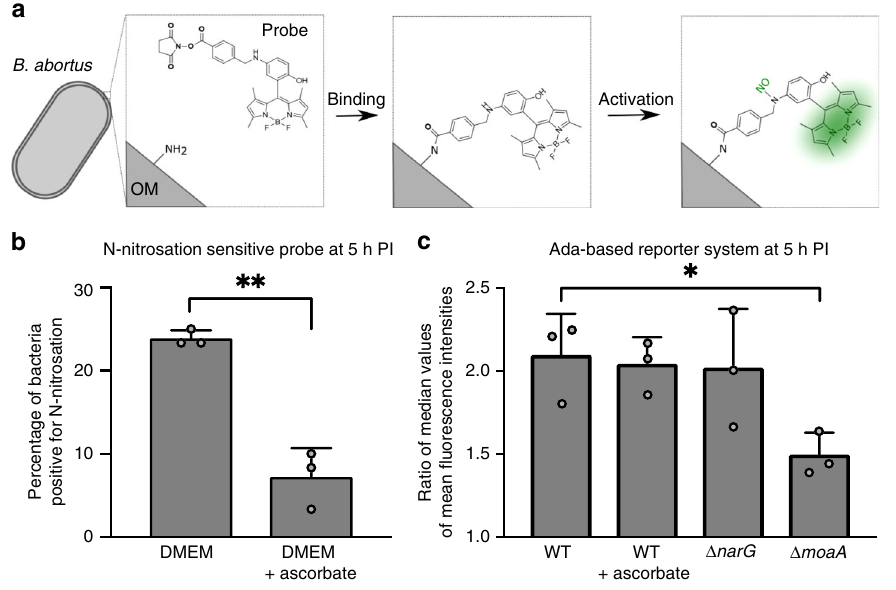
Fig. 3 Production of N-nitroso compounds inside host cells. a Schematic representation of the N-nitrosation-sensitive probe reacting with primary amine from B. abortus outer membrane (OM), and subsequently being activated by NO. b Evaluation of exogenous N-nitrosation by calculating the percentage of positive labeled bacteria. Bacteria were labeled with the N-nitrosation-sensitive probe and used to infect RAW 264.7 macrophages. Mean fl uorescence intensities were calculated at 5 h post infection ( n = 60) and values above 100 were considered as positive. The addition of 163 µ M of ascorbate to the cell culture medium at time 0 was used to inhibit N-nitrosation. Experiments were done in biological triplicates. Error bars correspond to standard deviation. Student ’ s t -test was performed with p < 0.01 (**). Source data are provided as a Source Data fi le. c Evaluation of endogenous N-nitroso compounds formation via the alkylation-sensitive reporter system. The Ada E. coli -based reporter system was used in three genetic backgrounds (WT, Δ narG , and Δ moaA ) and in the presence of ascorbate (for the WT background only). Bacteria carrying either the pBBR-p ada - ada - gfp reporter system or its mutated version ( ada C38A ) were used to infect RAW 264.7 macrophages and mean fl uorescence intensities were calculated at 5 h post infection ( n = 60). Ratio of median values ( ada / ada C38A ) was plotted for biological triplicates. Error bars correspond to standard deviation. A Student ’ s t -test was performed with a p < 0.05 (*). Source data are provided as a Source Data fi le